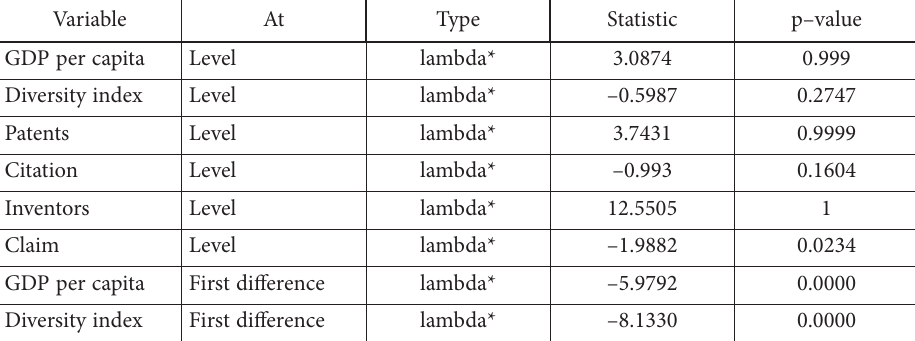
Table B.1. Stationary test results (using Breitung unit-root